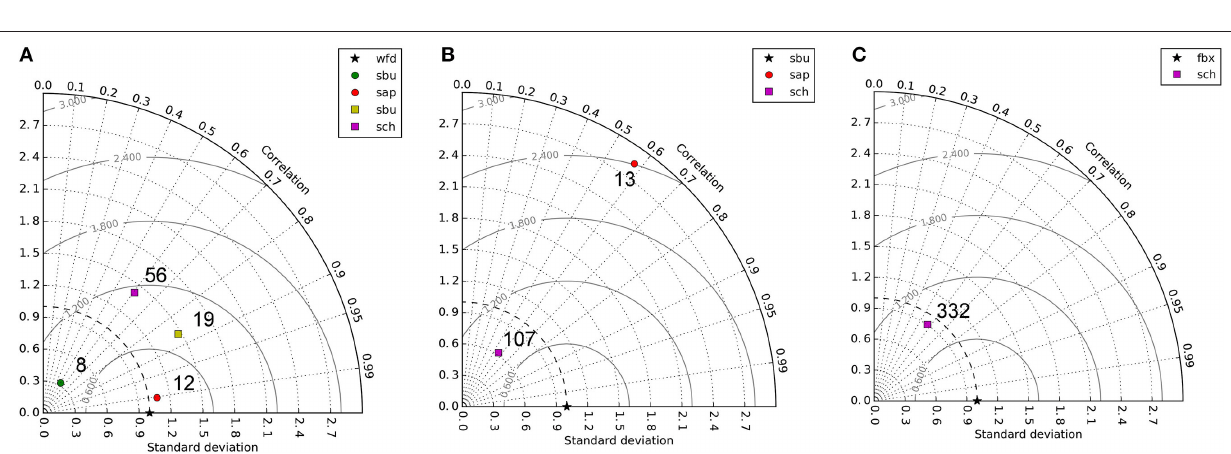
between sbu and sap , different variability, and high